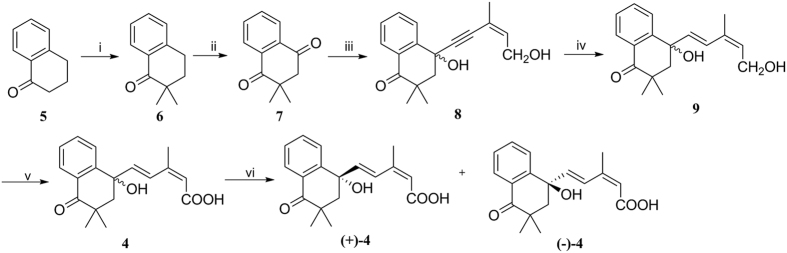
Synthesis of iso-PhABA 4.Reagents and conditions: i. MeI, NaH, THF; ii. Co(acac)2, t-BuOOH, acetone; iii. n-BuLi, (Z)-3-methylpent-2-en-4-yn-1-ol, THF, −78 °C; iv. Red-Al, THF, 0 °C; v. (A) DMP, DCM, r.t.; (B) NaClO2, 2-methyl-2-butene, NaH2PO4, t-BuOH:H2O = 3:1; vi. Chiral HPLC.